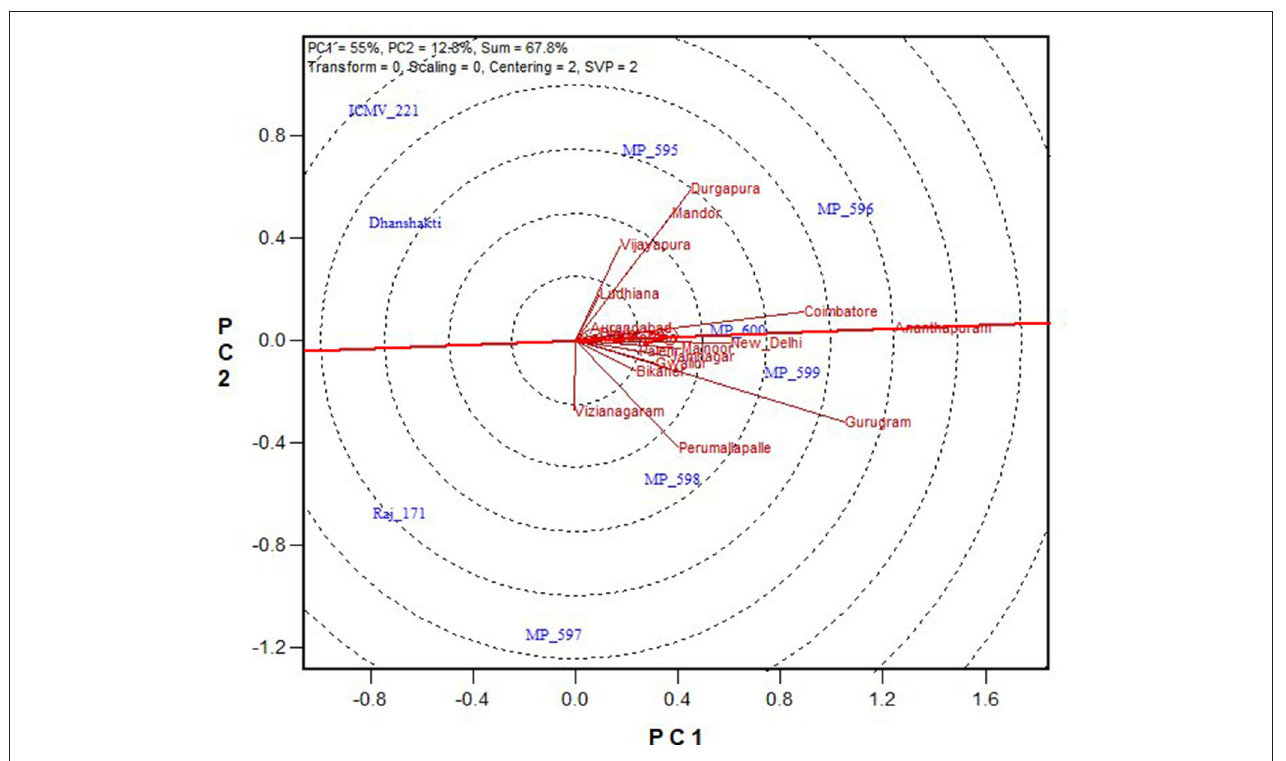
FIGURE 4 | Ranking of environments for grain yield based on discriminating ability and representativeness.